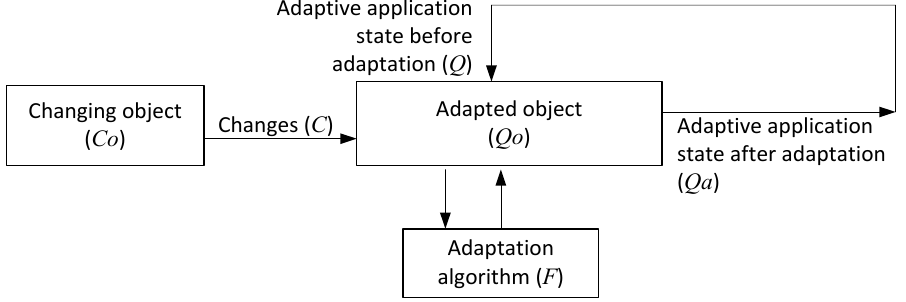
Figure 1. A simplified input/output view for the core concepts of the adaptive application